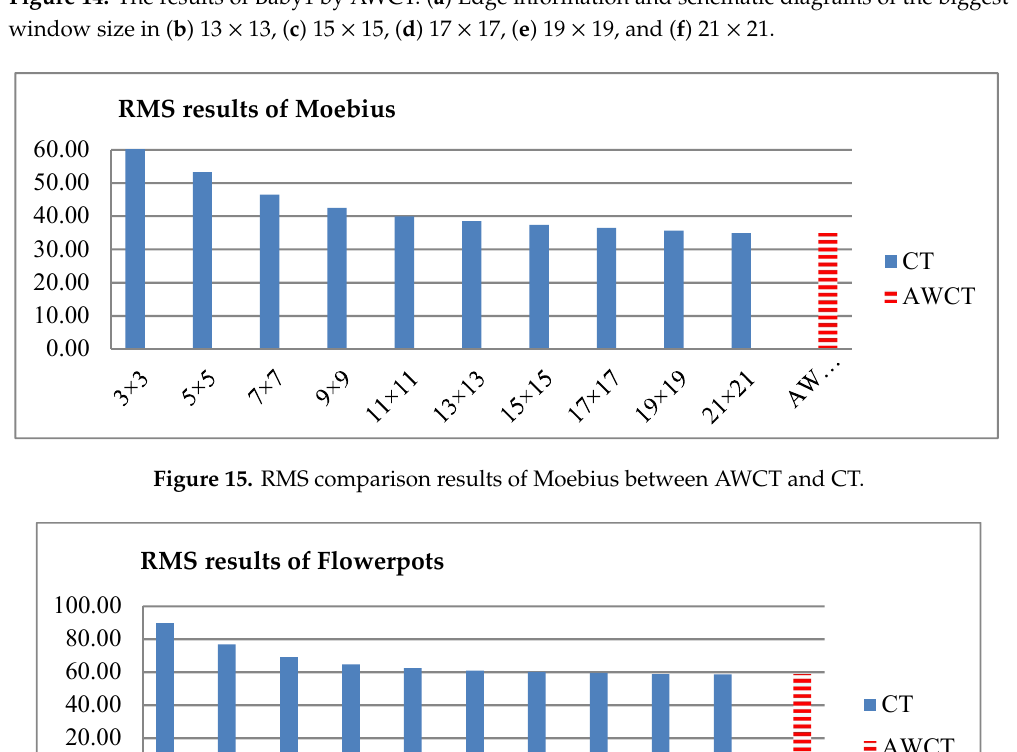
Figure 14. The results of Baby1 by AWCT. ( a ) Edge information and schematic diagrams of the biggest